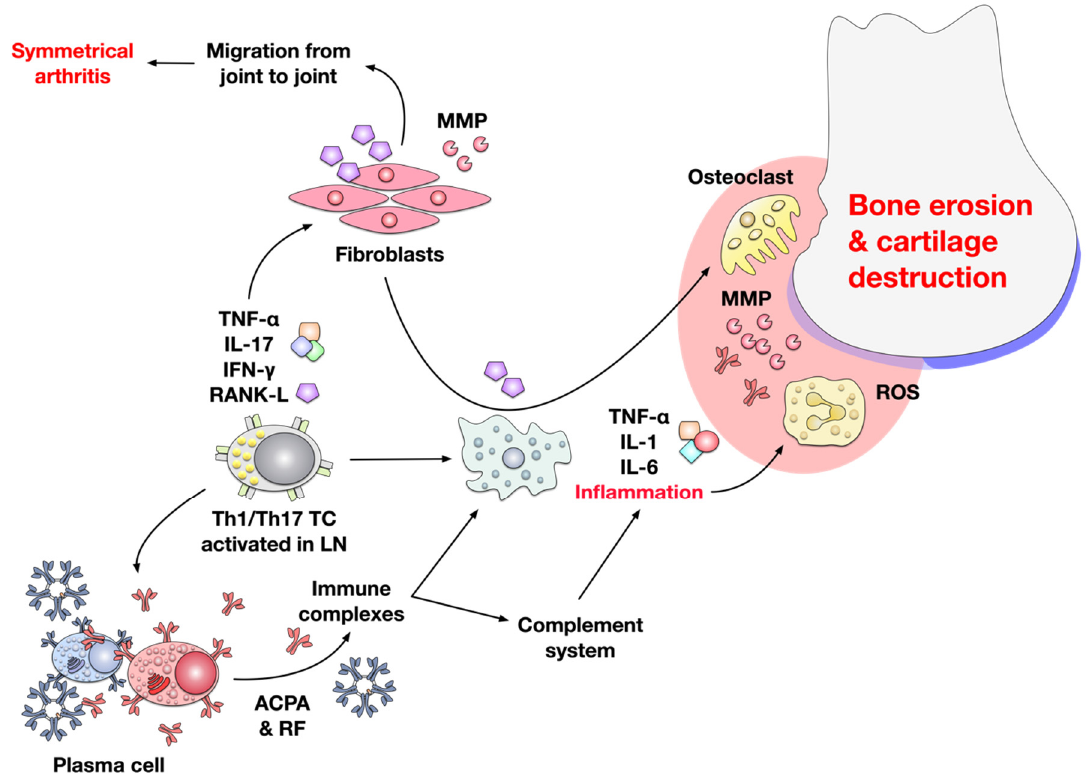
Figure 2. Pathomechanism of RA. Inflammation in RA is induced by autoreactive Th1- or Th17 T cells primed in the lymph nodes (LN) or locally by activated Antigen-presenting cells (APCs) that present autoantigen-derived peptides. In the affected joint, activated autoreactive T cells subsequently activate macrophages and fibroblasts via the secretion of the pro-inflammatory mediators TNF- α , IL-17, IFN- γ , and receptor activator of nuclear factor KB ligand (RANK-L). Activated macrophages in turn secrete large amounts of the strongly pro-inflammatory cytokines TNF- α , IL-1 β , and IL-6 which promote the establishment and maintenance of an inflammatory milieu in the synovium. Activated T cells also provide help to autoreactive B cells resulting in the production of anti-citrullinated protein antibodies (ACPAs) and rheumatoid factor (RF) autoantibodies. These autoantibodies further drive inflammation by either direct macrophage activation of triggering the complement cascade. In addition, RANK-L produced by the activated fibroblasts promotes the differentiation of osteoclasts from macrophages. Together with fibroblast-derived matrix metalloproteases (MMPs), osteoclasts, and antibodies, activated neutrophils mediate inflammation-dependent cartilage destruction and bone erosion.